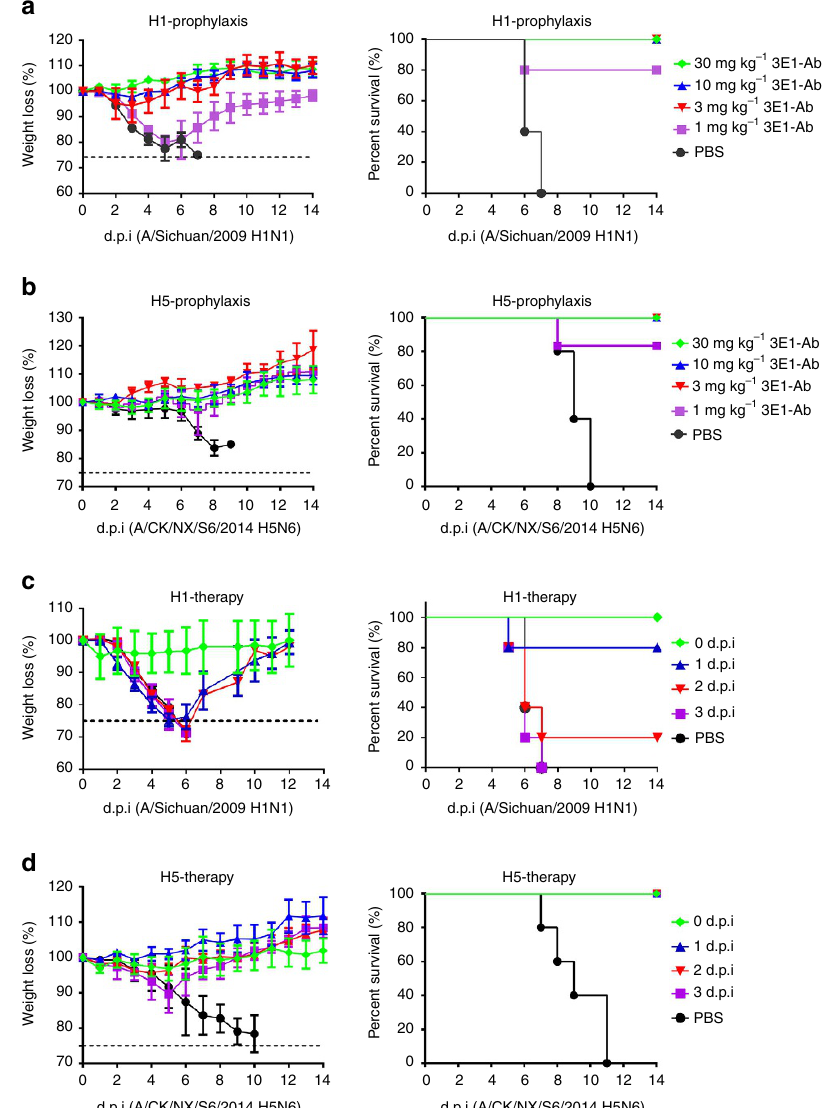
Figure 2 | Prophylactic and therapeutic efficacy of 3E1 mAb in mice. ( a , b ) Prophylactic efficacy of 3E1 mAb against a lethal challenge with the A/Sichuan/09/2009(H1N1) virus ( a ) or A/CK/NX/S6/2014(H5N6) virus ( b ). The weight loss (left) and survival curves (right) of mice treated with 30, 10, 3 or 1mgkg (cid:3) 1 of 3E1 mAb or PBS buffer 24h before lethal challenge by an intranasal inoculation with the H1-SC09 or H5-NX14 virus (at day 0) are shown. ( c , d ) Therapeutic efficacy of 3E1 mAb against a lethal challenge with the A/Sichuan/09/2009(H1N1) ( c ) or A/CK/NX/S6/2014(H5N6) virus ( d ). The weight loss (left) and survival curves (right) of mice treated with PBS buffer (at day 1) or 20mgkg (cid:3) 1 of 3E1 mAb right after or 1, 2, 3 days after lethal challenge by an intranasal inoculation with the H1-SC09 or H5-NX14 virus (at day 0) are shown. Error bars represent mean ± s.d. Data represent a representative experiment from three independent experiments. chain of Tyr52 of HCDR2 forms a hydrogen bond with the main-chain carbonyl of Gly16 of the fusion peptide, the main-chain amine of Ile101 of HCDR3 forms a hydrogen bond with the main-chain carbonyl of Val18 of the fusion peptide, and the side chain of Arg50 of HFR2 forms a salt bridge with the side chain of Asp19 of the fusion peptide (Fig. 3d). Additionally, Tyr33 of HCDR1 makes hydrophobic contacts with Val18 and Asp19 of the fusion peptide, Tyr52 of HCDR2 makes hydro- phobic contacts with Val18 of the fusion peptide, and His100, Ile101 and Phe103 of HCDR3 form extensive hydrophobic interactions with Val18, Asp19, Gly20 and Trp21 of the fusion peptide (Fig. 3d). At the upper part of the interacting interface, the HCDR3 loop and the three LCDR loops mainly interact with the F subdomain NATURE COMMUNICATIONS|7:13577|DOI: